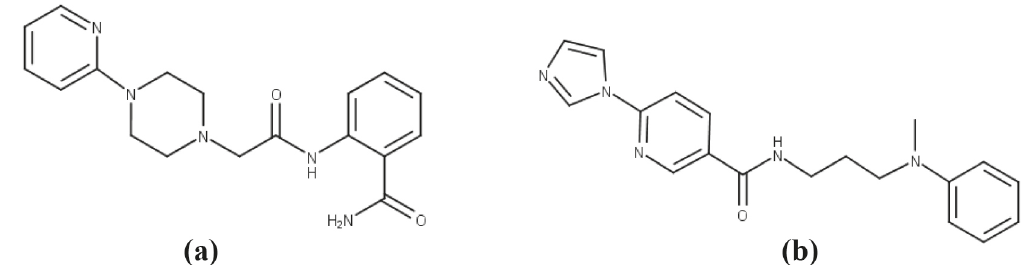
FIGURE 29 - Structures of compounds a and b, inhibitors of the CXCR3-CXCR4